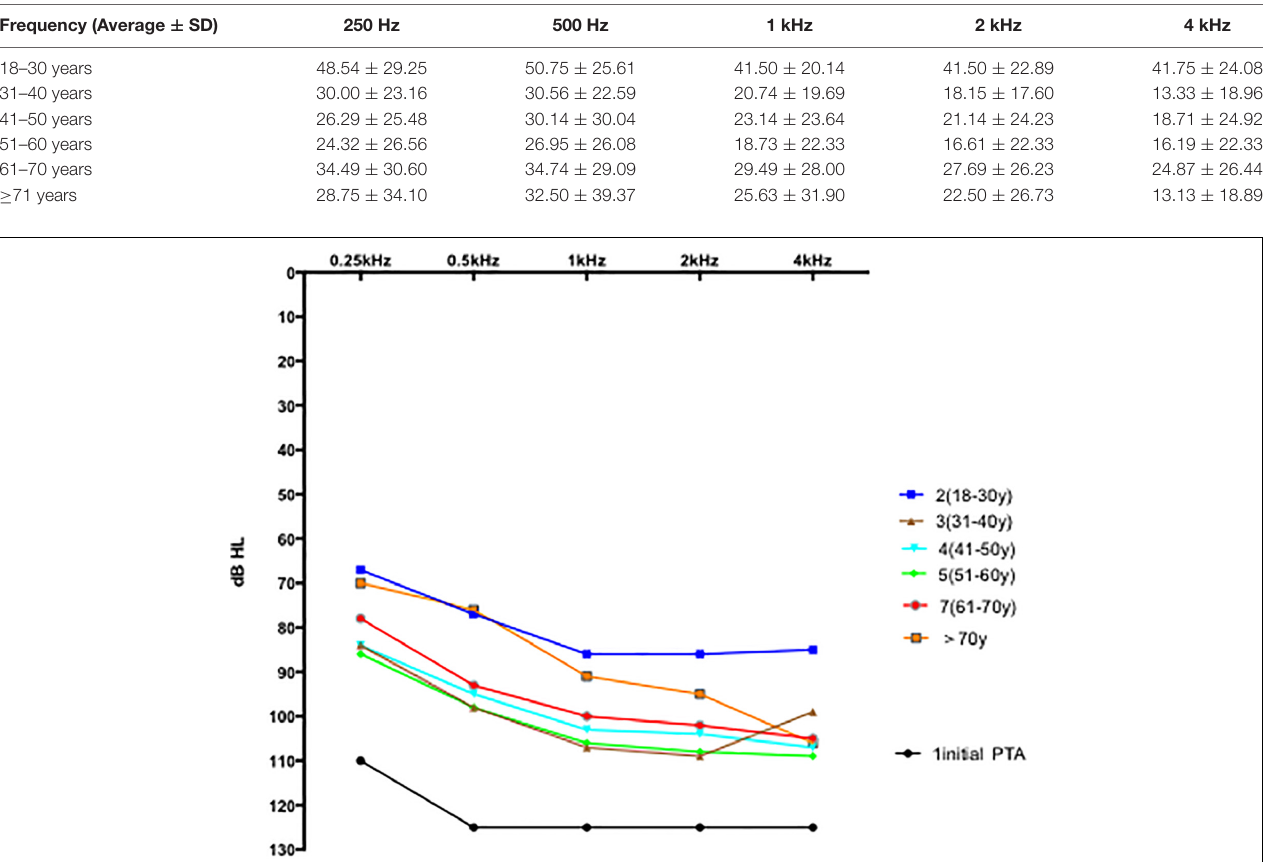
TABLE 5 | Mean hearing gain values at each octave frequency 1 month posttreatment in the six groups. Frequency (Average ± SD) 250 Hz